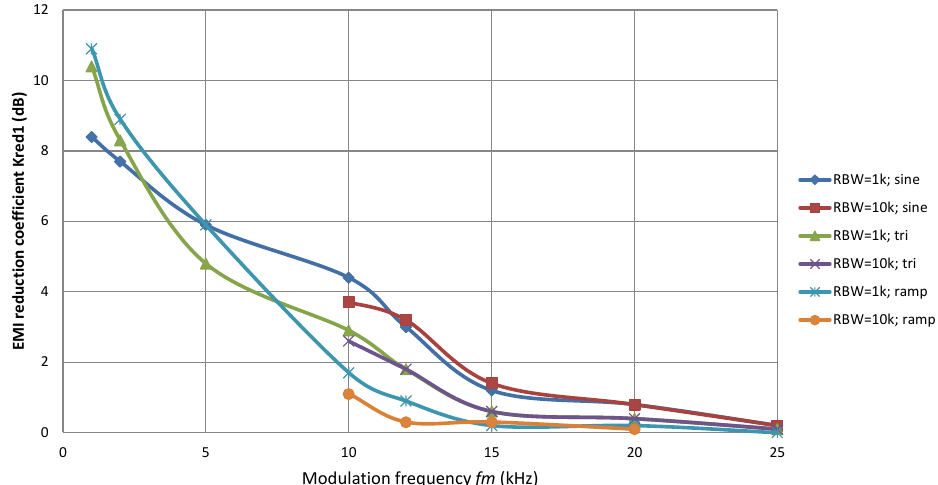
Figure 10. Comparison of spectra of radiated emissions from the WPT system without spread spec- trum and with spread spectrum based on multi-frequency technique: ( a ) 3-frequency technique, f m = 2 kHz, f 1 = 140.4 kHz, f 2 = 151.1 kHz, f 3 = 160.3 kHz, Δ f = 20 kHz; RBW = 1 kHz; ( b ) 4-frequency technique, f m = 0.35 kHz, f 1 = 145.3 kHz, f 2 = 148.8 kHz, f 3 = 151.1 kHz, f 4 = 154.3 kHz Δ f = 9 kHz; RBW = 0.1 kHz.